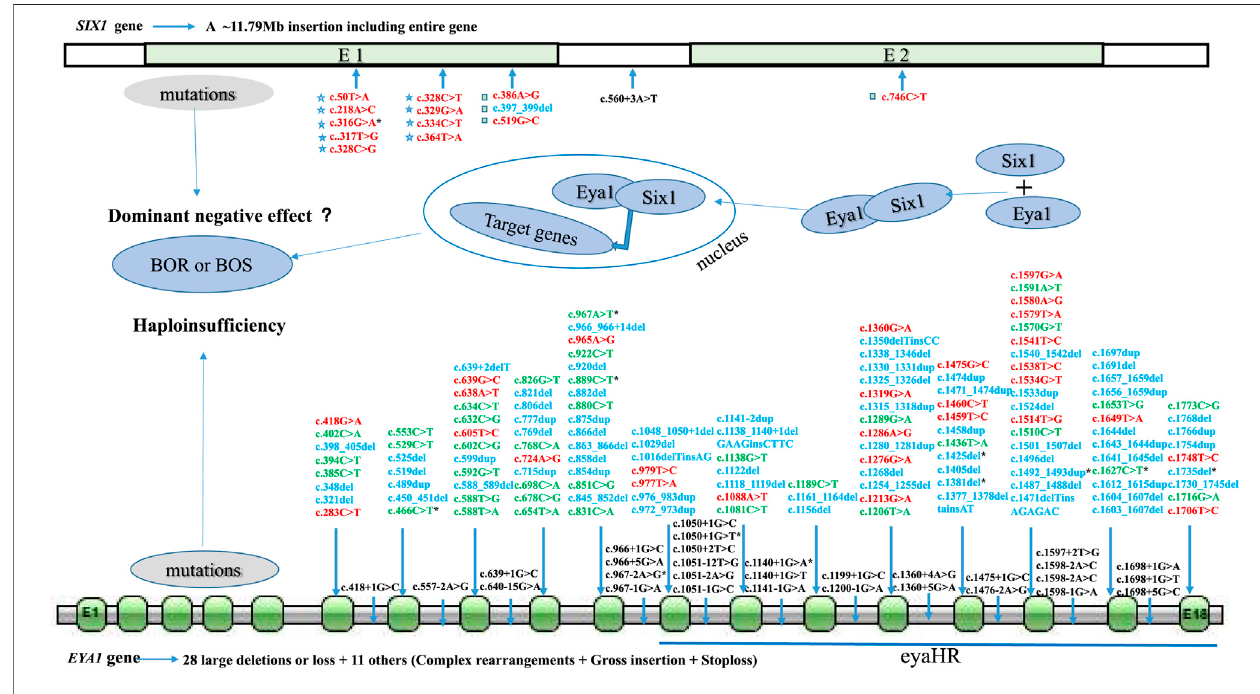
FIGURE 3 | Mutational spectrum of BOR/BOS-related genes ( EYA1 and SIX1 ). E : exon; red: missense; green: nonsense; blue: frameshift; black: splicing site; pentagram: SIX domain of Six1 protein; square: homeodomain of Six1 protein; asterisk: variants in Chinese patients.